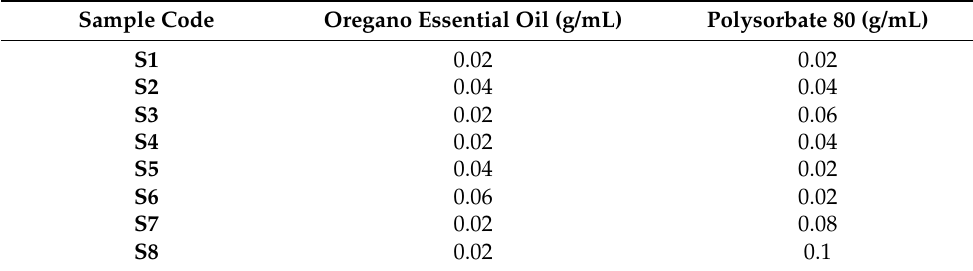
Table 3. The compositions of the emulsions (expressed in weight-to-milliliter ratio). Sample